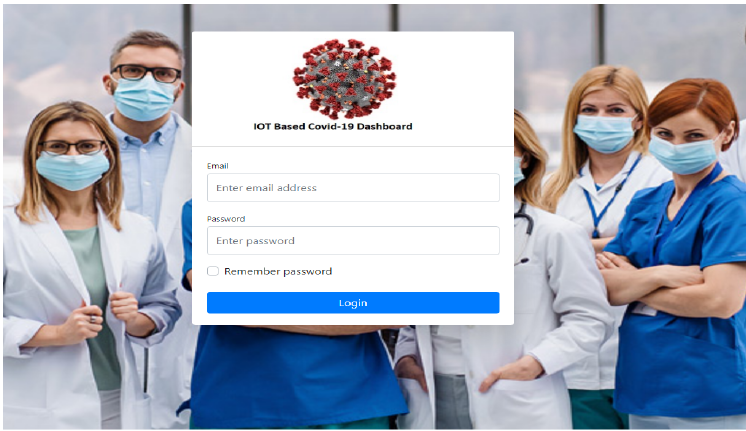
Figure 21. Login form of web portal for COVID-19 data